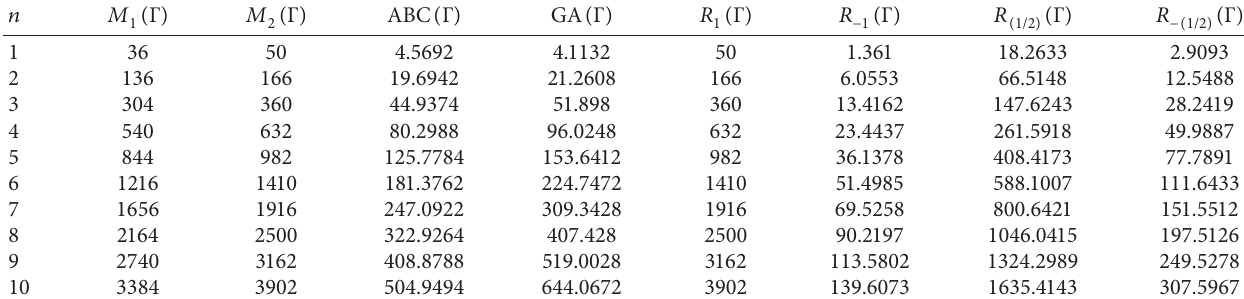
( Γ ) , M ( Γ ) , ABC ( Γ ) , GA ( Γ ) , R 1 2